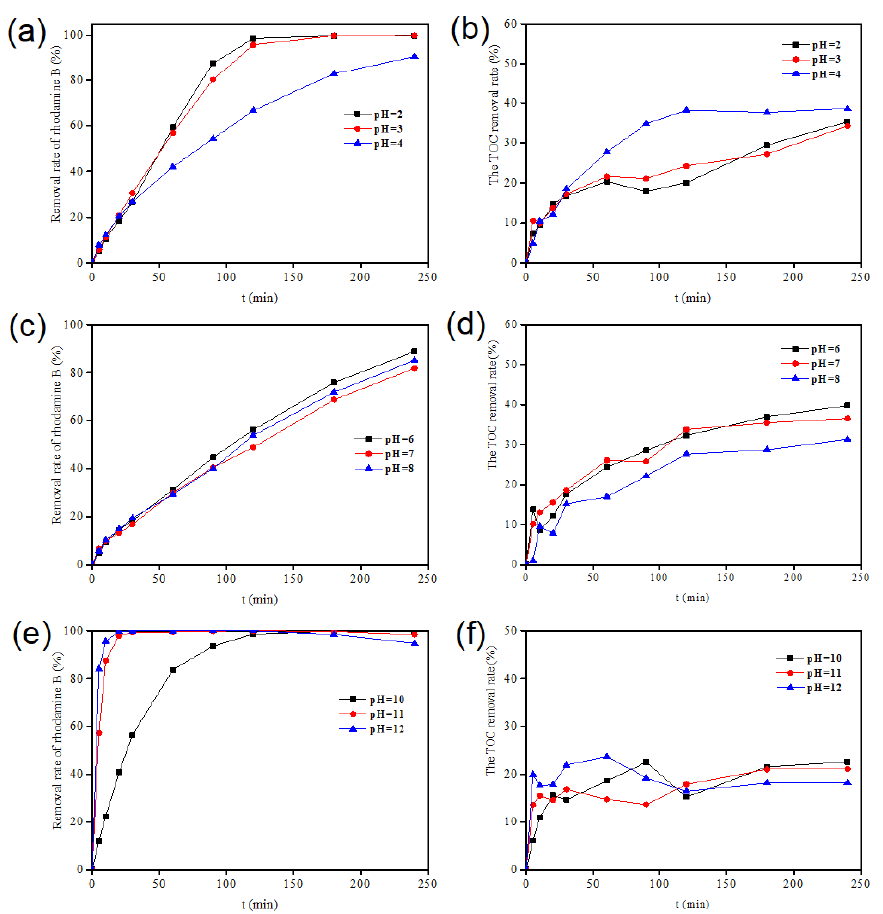
Figure 5. Effects of different pH values on the removal rate and mineralization rate of rhodamine B ( 𝑐 0 = 200 mg/L, catalyst = 10 g/L, T = 55 °C, 𝑐 𝐻